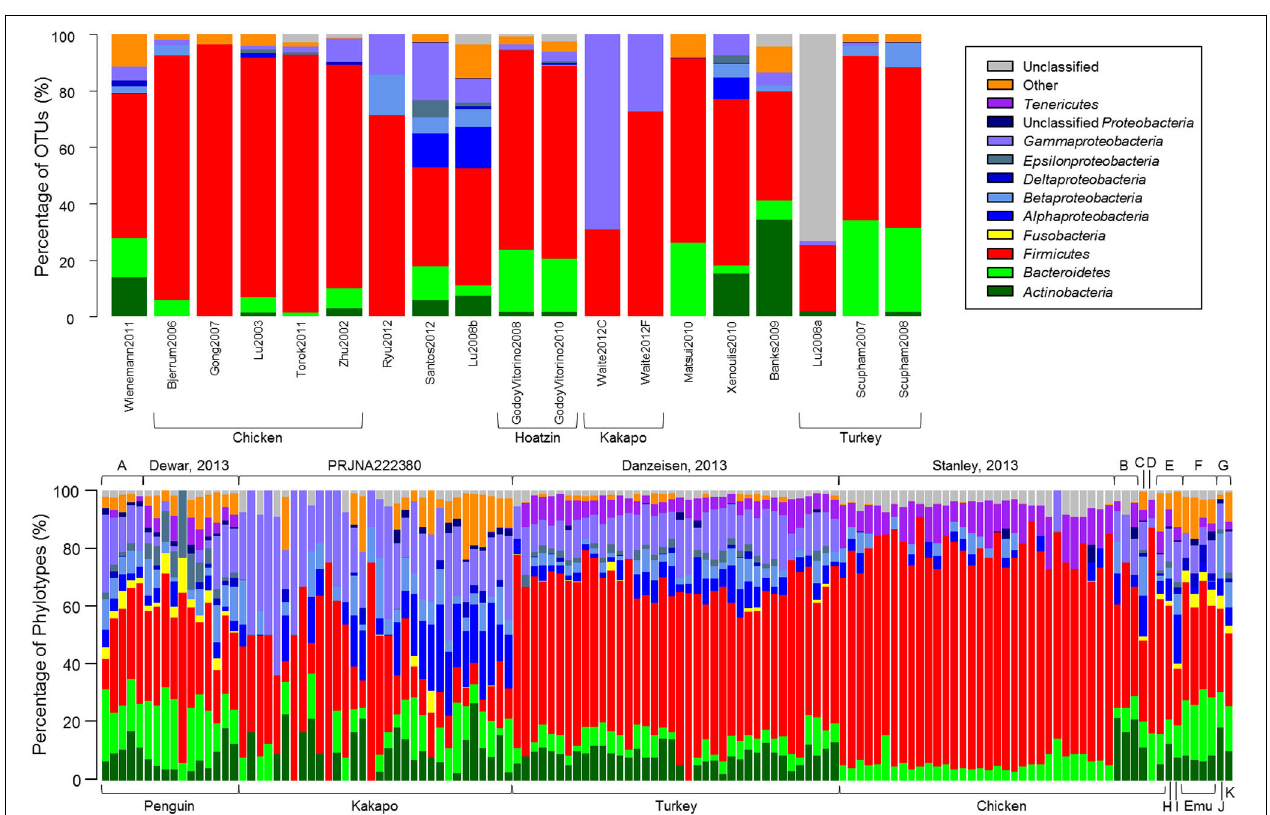
FIGURE 1 | The relative proportion of OTUs represented in each study. OTUs were constructed by calculating average-neighbor distance between aligned 16S rRNA gene sequences in mothur and classified as a cluster of sequences with ≥ 97% similarity. Taxonomic classification for each OTU was derived from a consensus taxonomic classification of each sequence assigned to the OTU. (Top) Samples from clone-library data. (Bottom)